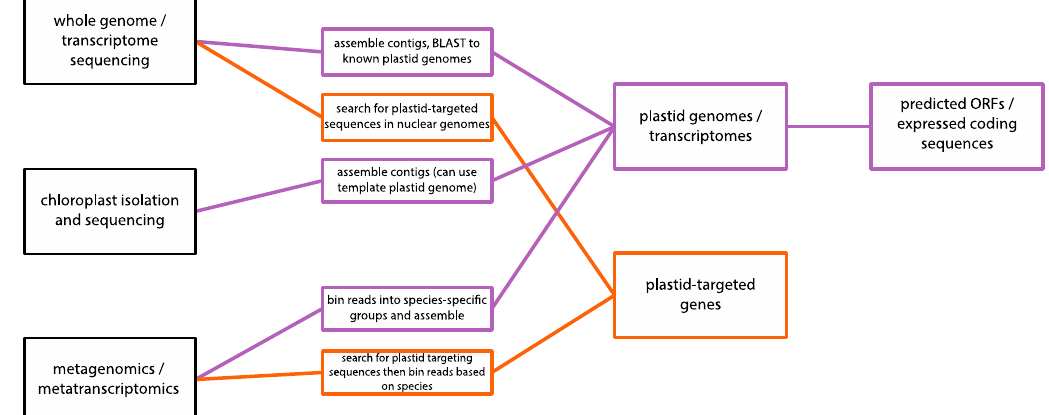
Figure 2. Methodology for identifying plastid genome sequences and plastid-targeted genes from various types of sequencing: genome / transcriptome sequencing projects, where the DNA is extracted from a cultured organism or single cell; chloroplast isolation and sequencing, where DNA is extracted from purified chloroplasts; and metagenomics / metatranscriptomics, where DNA from a microbial community is extracted and sequenced directly from an environmental sample.